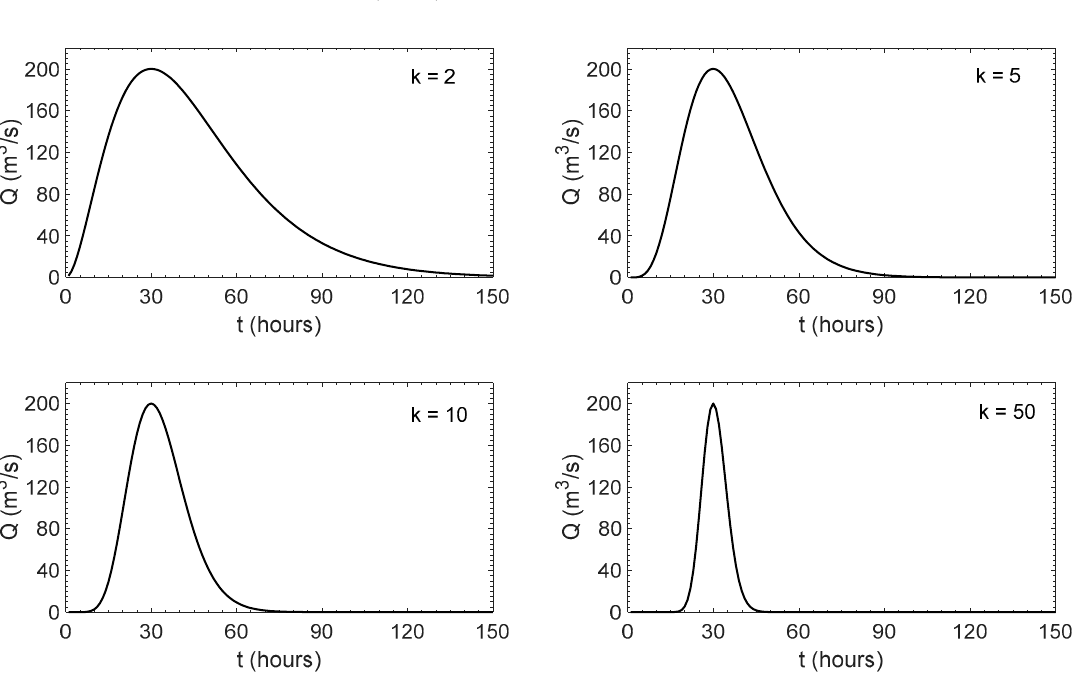
Figure 1. Equation (5) for different values of k (= 2, 5, 10, 50). Peak discharge 200 (m 3 /s) and time to peak 30 (hours).